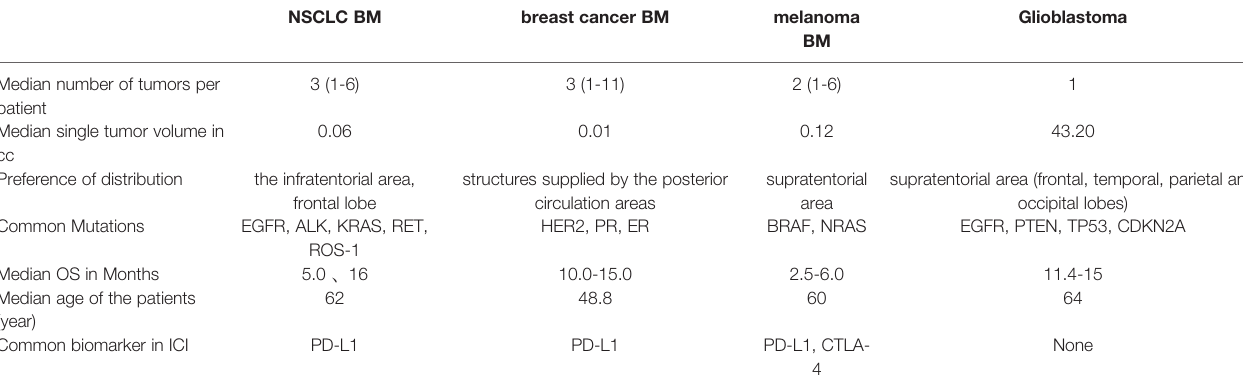
TABLE 1 | Contrast of NSCLC BM, breast cancer BM, melanoma BM and primary brain cancer